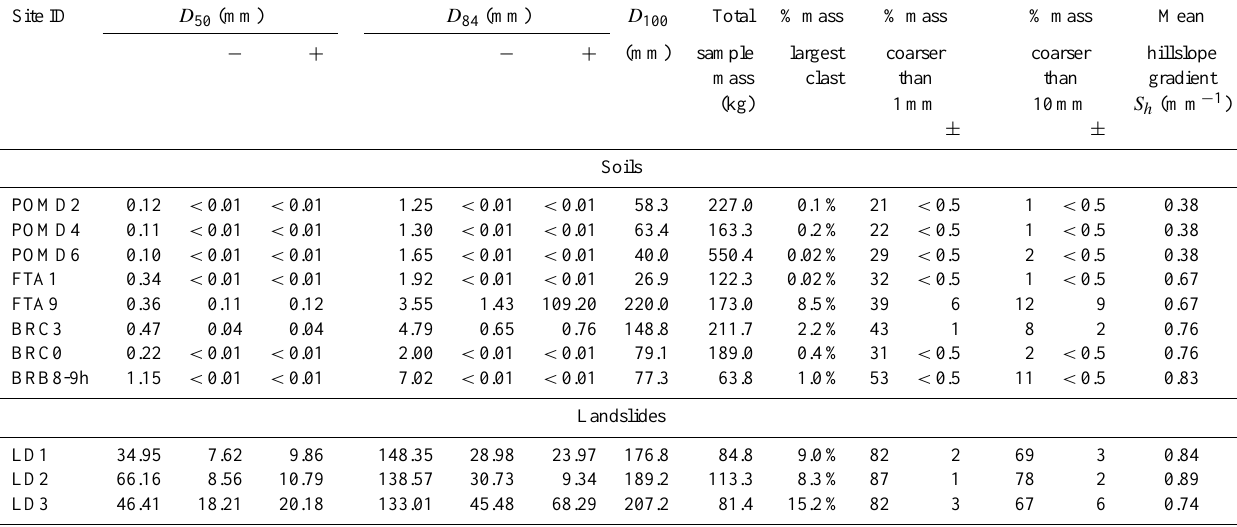
Table A1. Description of hillslope sites data. D 100 is maximum grain size. Plus or minus values are calculated according to procedure described in Sect.